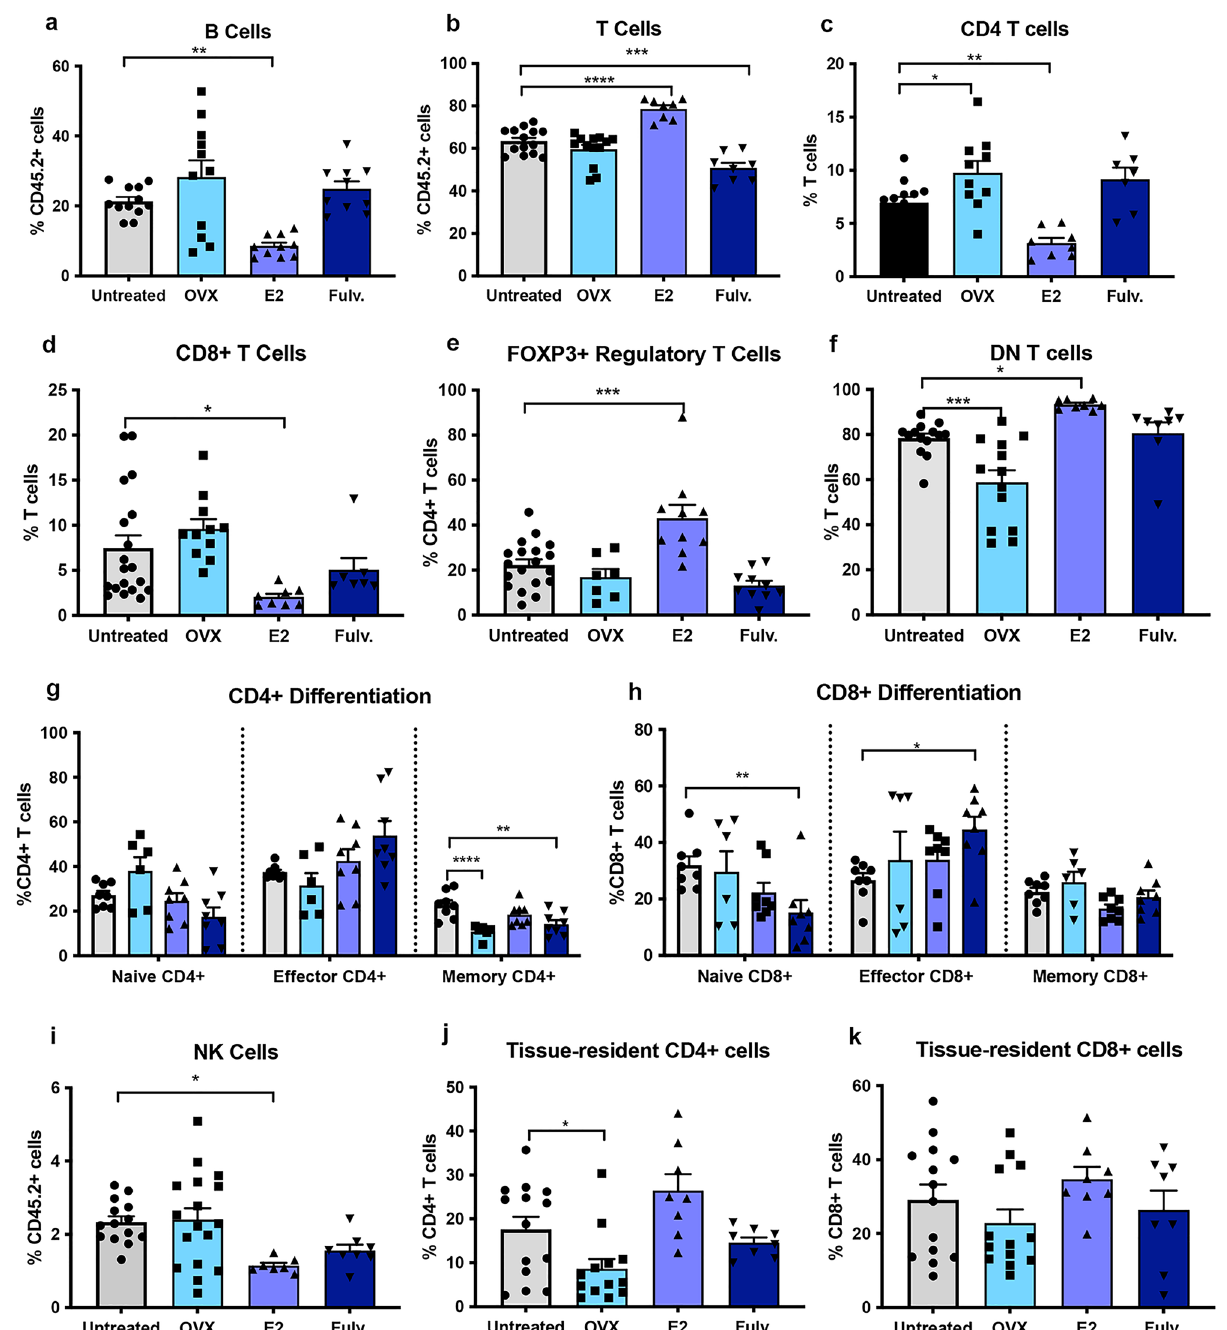
Figure 2. Effects of estrogen, oophorectomy and fulvestrant on the adaptive immune cells within the non-neoplastic mouse mammary gland. Mice were either untreated, ovariectomised (Ooph) or treated for 6 weeks with estrogen (E2) or Fulvestrant (Fulv). ( a ) B cells, ( b ) T cells, ( c ) CD4 + T helper cells, ( d ) CD8 + cytotoxic T cells, ( e ) FoxP3 + regulatory T cells, ( f ) CD4- CD8- T cells, ( g ) CD4 + differentiation status, ( h ) CD8 + differentiation status, ( i ) NK cells, ( j ) tissue resident CD4 + T cells and (k) tissue resident CD8 + T cells. Results are expressed percentage of immune cells (mean ± SEM). n = 11–17 mice/group. Data was analysed using a Turkey multiple comparisons one-way ANOVA if confirmed Gaussian distribution, or Kruskal–Wallis multiple comparisons 1-way ANOVA if non-Gaussian. Statistically significant results are denoted with *p < 0.05, **p < 0.01, ***p < 0.001, ****p <